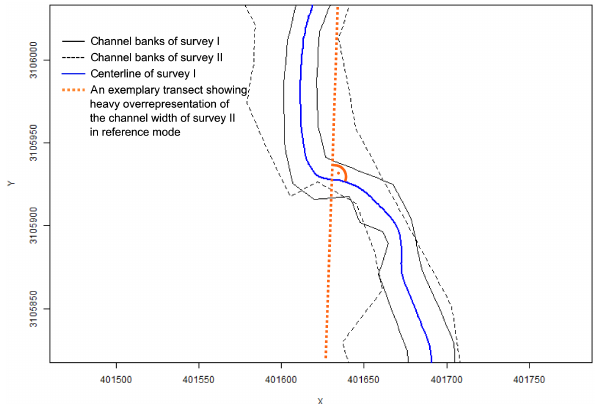
Figure 6. Two consecutive channel geometries (surveys I and II) with a profound reorganization of the channel bed. In the reference mode a centerline of one survey is used to build transects. Here, using the centerline of the first survey (blue line) as a reference is not suitable to capture the channel width correctly for the second survey (dashed line) as the exemplary transect (dashed orange line) suggests.